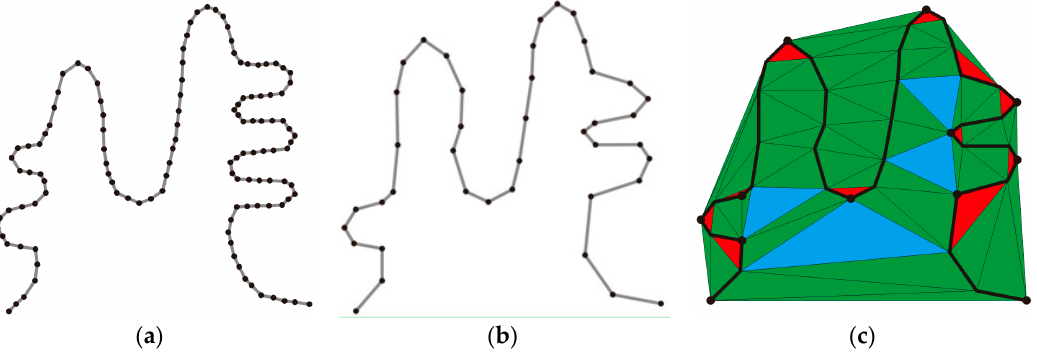
Figure 2. The experimental data with different levels of details and the characteristic point extraction from coarse representation of small scale. ( a ) Large-scale representation (1:10,000). ( b ) Small-scale representation (1:50,000). ( c ) Detection of characteristic points.